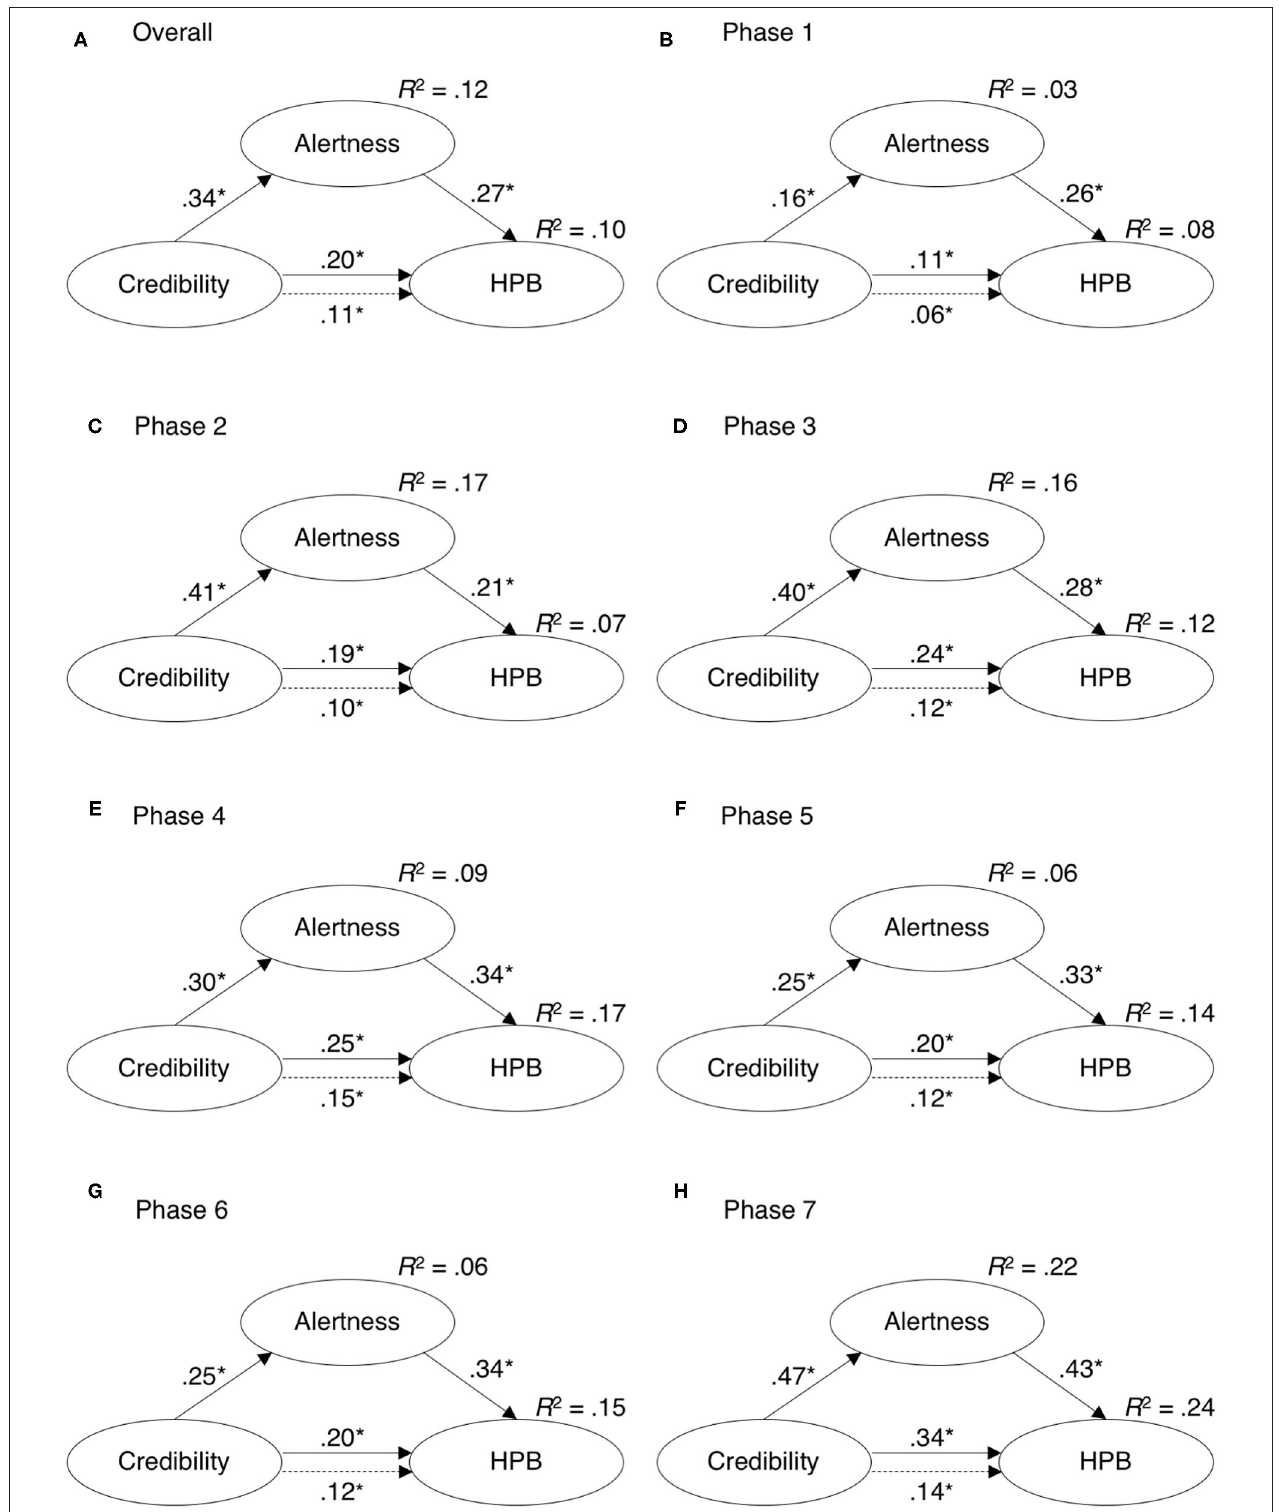
FIGURE 7 | Mediation analysis results for predicting engagement in hypothetical protective behavior (HPB) from perceived credibility of information in (A) the entire duration of measurement and (B–H) in different psychological phases of the epidemic.